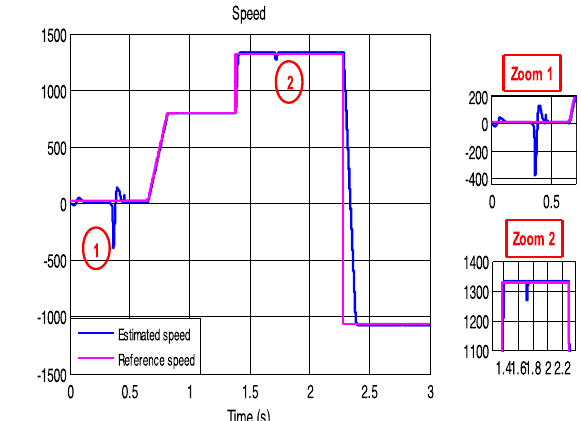
Fig. 16 FL-DTC stator current components